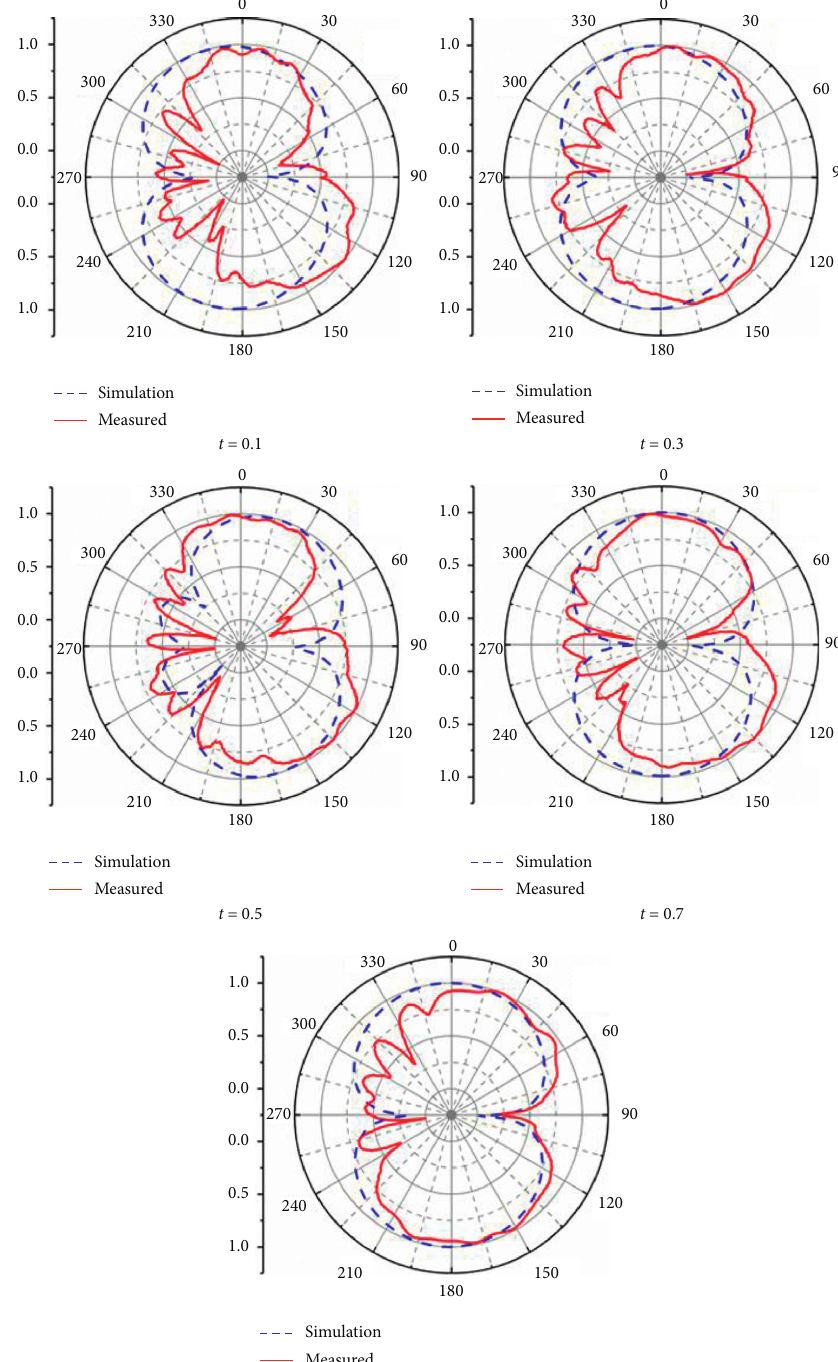
Figure 10: E-plane pattern with different t